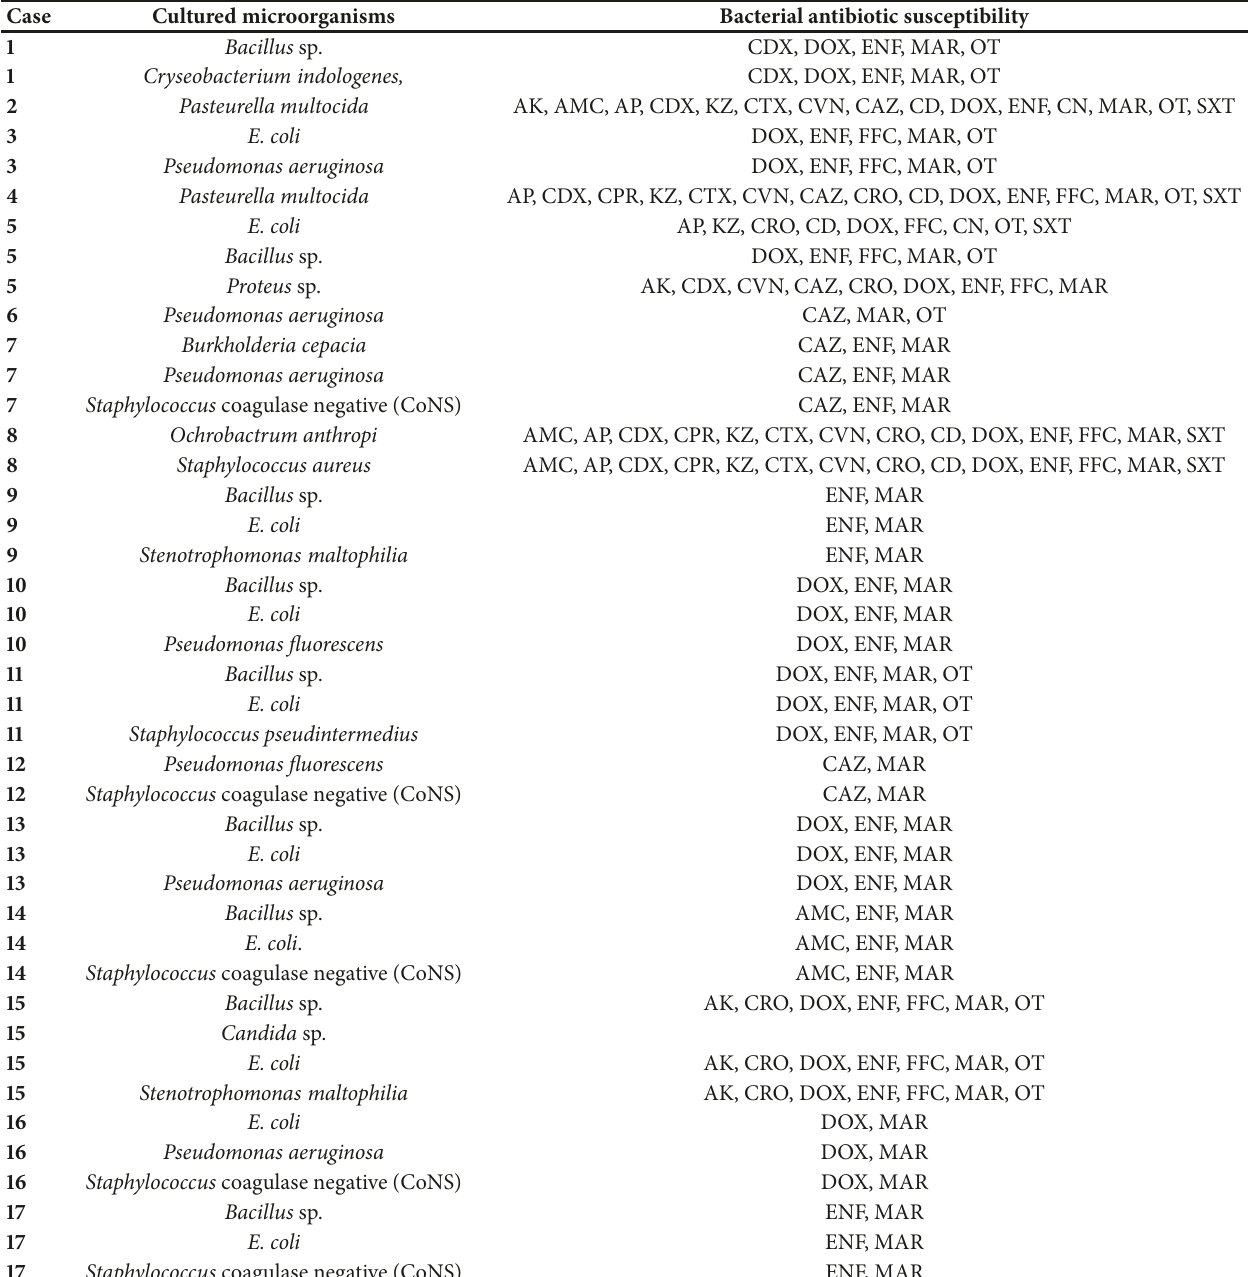
Table 4: Microbial isolates from vegetable foreign bodies extracted from lower respiratory tract and their antibiotic